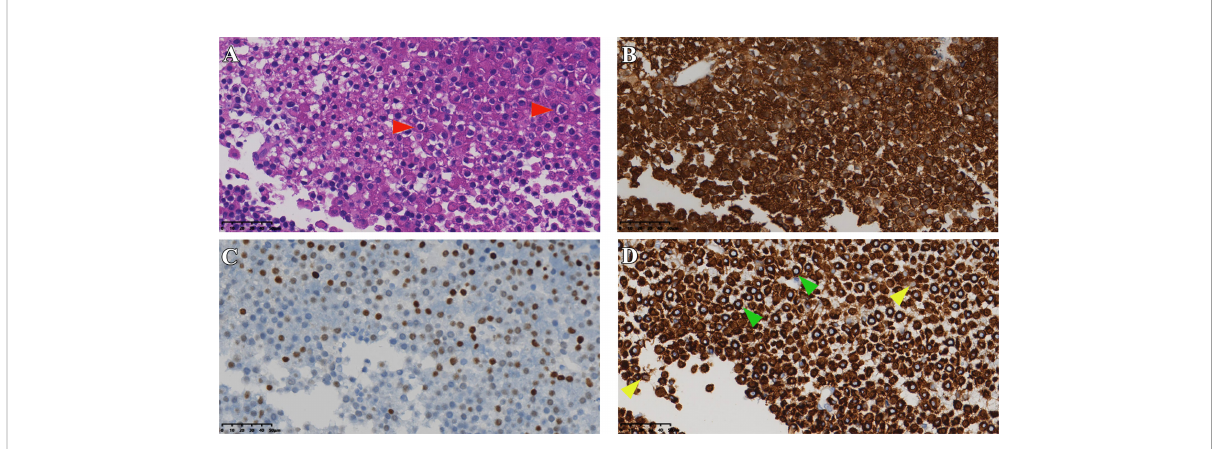
FIGURE 7 Histopathological staining of case 4. (A) HE staining of tumor tissue (red arrows indicate typical Crooke ’ s hyaline change). (B, C) Immunohistochemical staining for ACTH and T-PIT . (D) Immunostaining of CK8/18 (green and yellow arrows show a round and semi-circular pattern, respectively). Original magni fi cation, 40×.